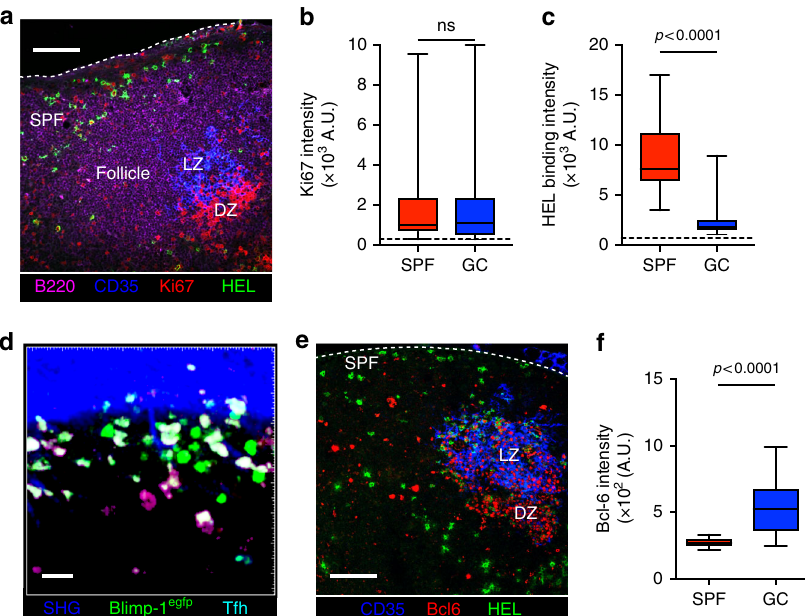
Fig. 4 MBCs differentiate into plasma cells in SPF. a Representative histological section of lymph node 3 days after secondary immunisation. CD35 (blue), Ki67 (red), HEL binding (green), B220 (pink). Scale bar = 100 μ m. b Quanti fi cation of Ki67 intensity on HEL-binding cells in SPF, n = 57, or GC, n = 72, from a . Comparison between groups utilised Mann – Whitney U test. c Quanti fi cation of HEL-binding intensity on HEL-binding cells in SPF, n = 57, or GC, n = 72, from a . Comparison between groups utilised Mann – Whitney U test. d Orthogonal maximum intensity projection (200 × 200 × 10 μ m) 3 days after secondary immunisation showing Blimp-1 + cells (green), Tfh cells (cyan), SHG (blue). Note auto fl ourescent macrophages. Scale bar = 20 μ m. e Representative histological section of lymph node 5 days after HEL-OVA re-immunisation. CD35 (blue), Bcl6 (red), HEL binding (green). Scale bar = 100 μ m. f Quanti fi cation of Bcl-6 intensity on HEL + cells in SPF B cells, n = 26, or GC B cells, n = 46. Data are representative of 5 independent experiments. Comparison between groups utilised Mann – Whitney U test. Box plots show centre line as median, box limits as upper and lower quartiles, whiskers as minimum to maximum